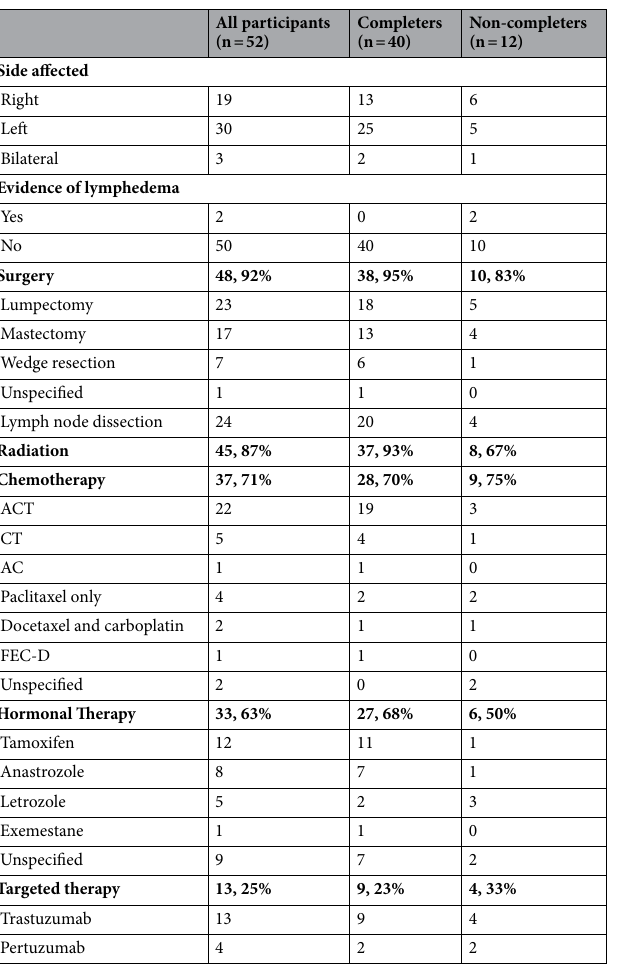
Table 2. Clinical and treatment characteristics. Data are n, % No significant differences between completers (n = 40) and non-completers (n = 12). AC doxorubicin (Adriamycin) and cyclophosphamide (Cytoxan), ACT doxorubicin (Adriamycin) and cyclophosphamide (Cytoxan), followed by paclitaxel (Taxol) or docetaxel (Taxotere), CT cyclophosphamide (Cytoxan) and paclitaxel (Taxol) or docetaxel (Taxotere), FEC-D 5-fluorouracil-epirubicin-cyclophosphamide followed by docetaxel. Bold is used to highlight the number and proportion of patients who received each major class of treatment (e.g., sugergy, radiation, chemotherapy etc.), versus individual drugs or forms of